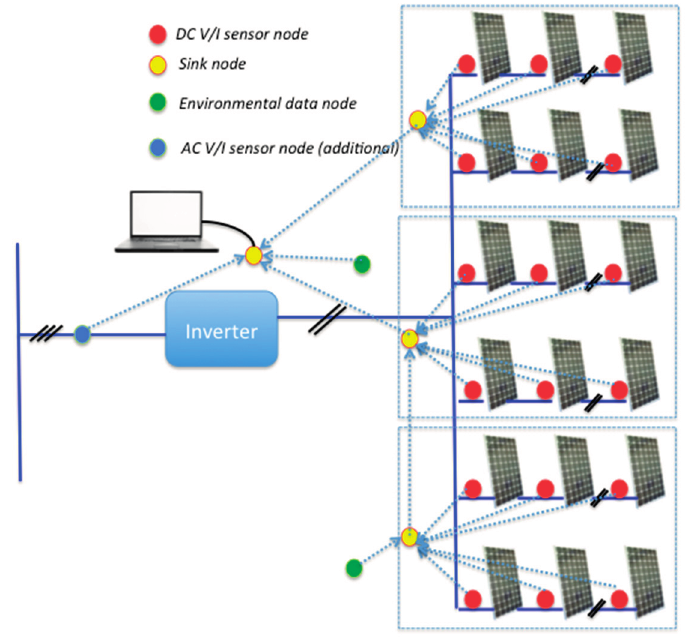
Figure 2. General scheme of the proposed wireless